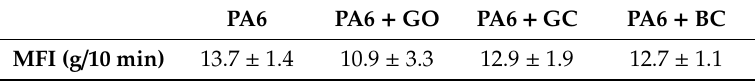
Figure 4. Microstructure of PA6 composites modified with ( a ) graphene oxide (GO), ( b ) glassy carbon particles (GC), and ( c ) biocarbon (BC); arrows indicate carbon components. Table 1. Melt flow index of PA6 composites and reference